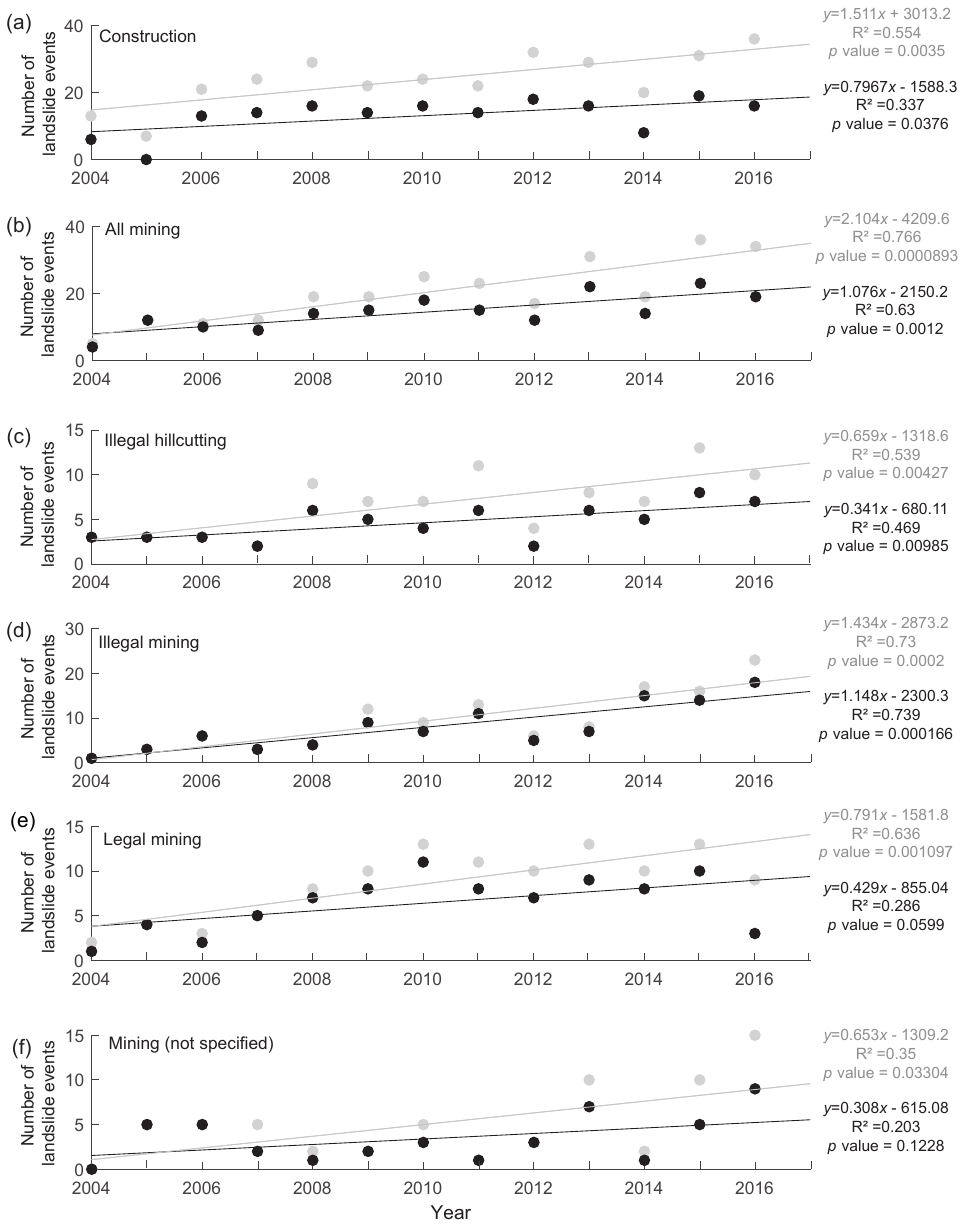
Figure 8. Number of landslide events triggered per year by (a) construction, (b) mining, (c) illegal hill cutting, (d) illegal mining, (e) legal mining and (f) mining (not specified). The black series contains only multi-fatality landslide events. The grey series contains single and multi-fatality landslide